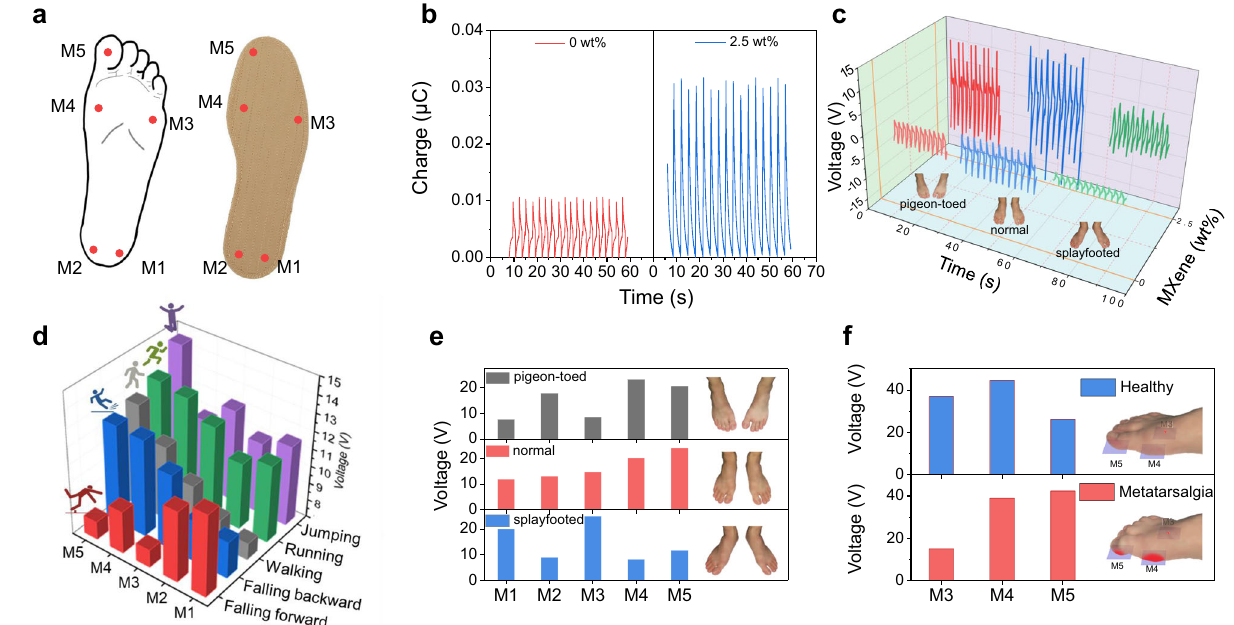
Fig.6|Outputperformanceandsensingapplicationofas-preparedMPCbased soft PT sensors. a Schematic of a smart insole integrated with fi ve PT sensors on fi ve different sites to form a foot sensor network. b Piezoelectric charges of undoped fi ber and MPC fi ber on M5 site in response to an adult ’ s (75kg) toe